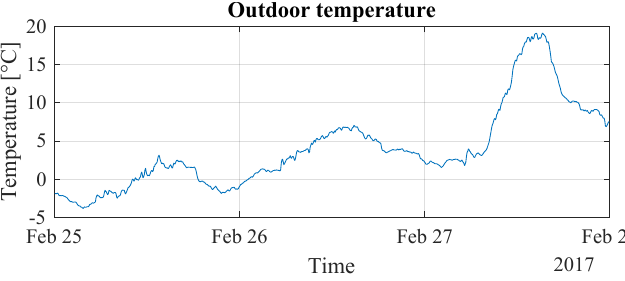
Figure 18. Outdoor temperature on 25–27 February 2017.